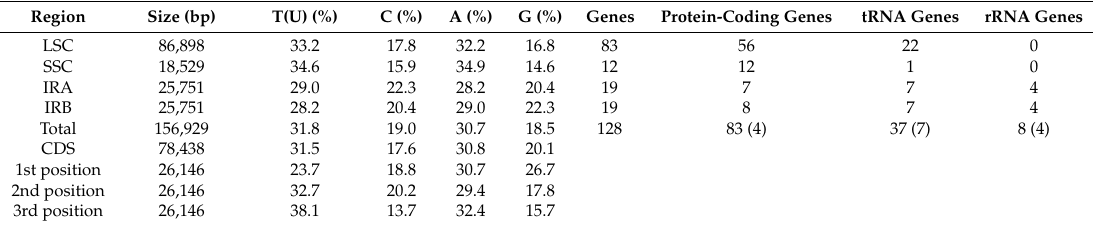
Table 1. Chloroplast genome composition of Talinum paniculatum ( Jacp )